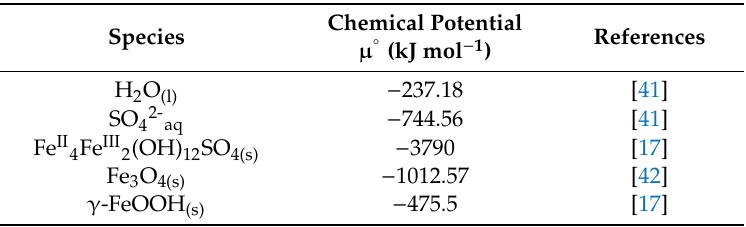
Table A1. Standard chemical potential of the various